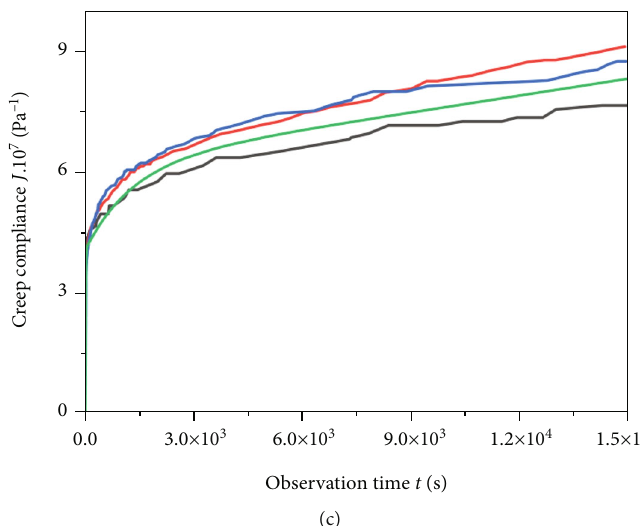
Figure 8: Compliance J vs. creep time t curves with loads1-3 for creep time: (a) t = 1 min , (b) t = 13 min , and (c) t = 250 min . The green line represents the predicted compliance value with the model parameters averaged for the three loads. The black, red, and blue lines represent data for load1, load2, and load3,